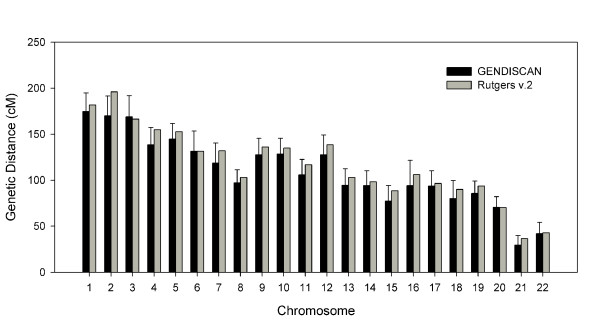
Comparison of male genetic lengths of the chromosomes between the GENDISCAN map and Rutgers Map v.2. Error bars represents the 95% confidence intervals from the paired t-tests.